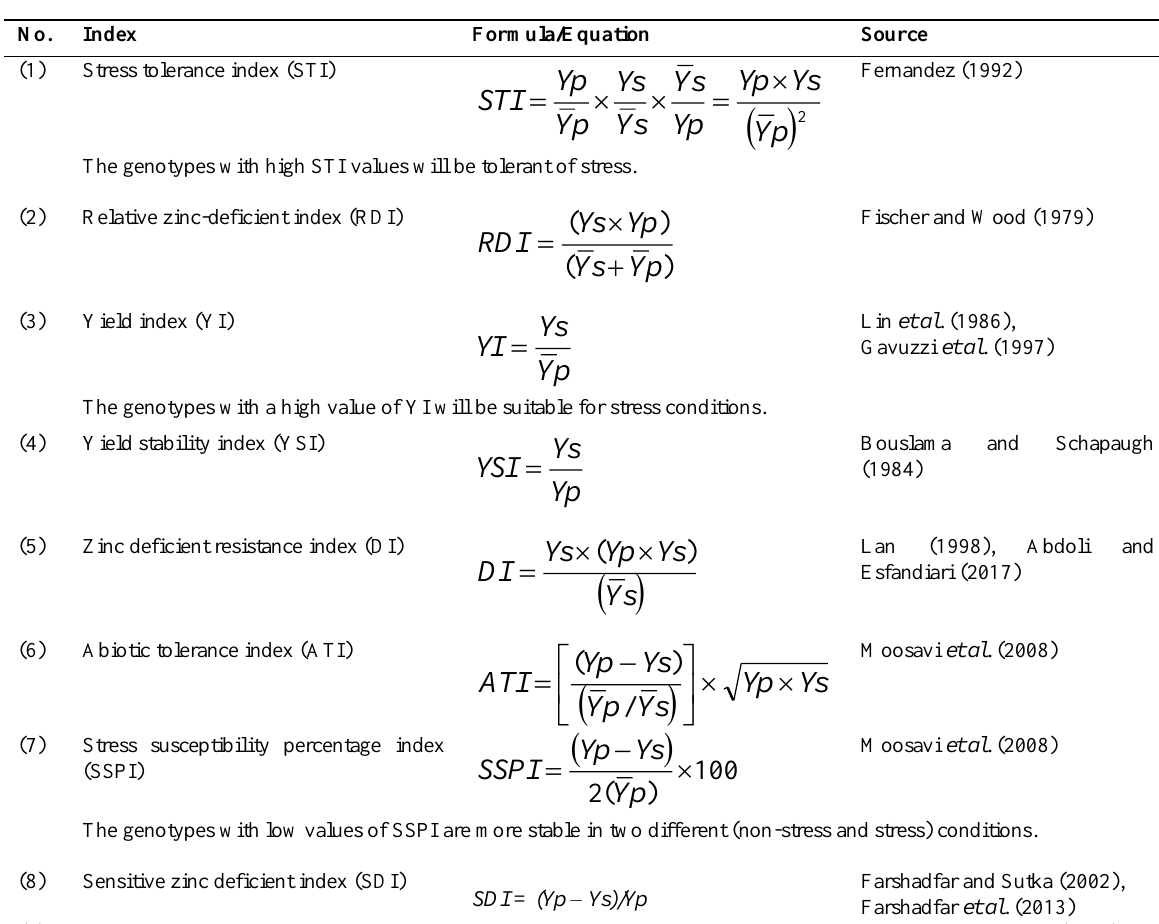
Table 2. Formulas of zinc stress tolerance